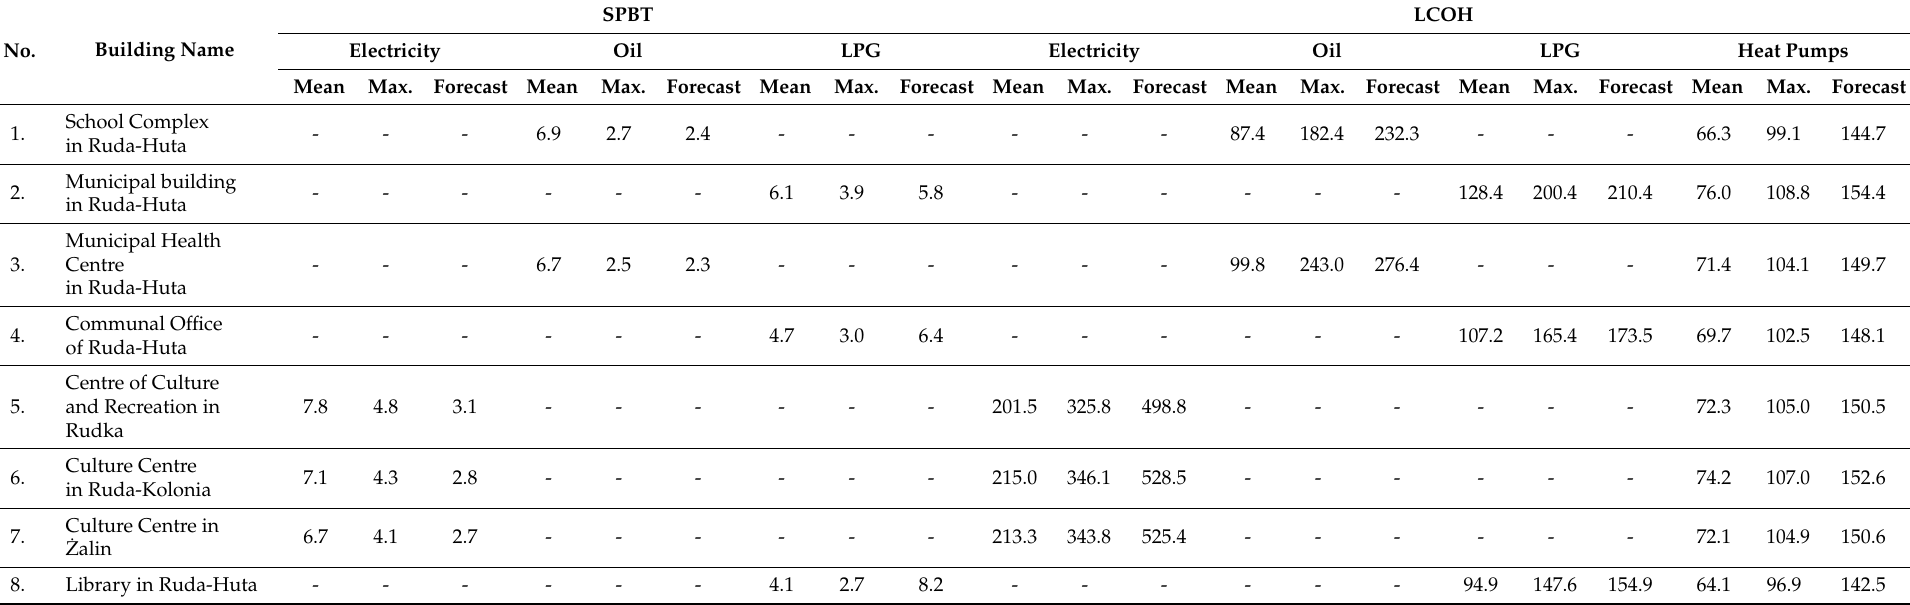
Table 5. SPBT and LCOE dependence on heating systems and fuel